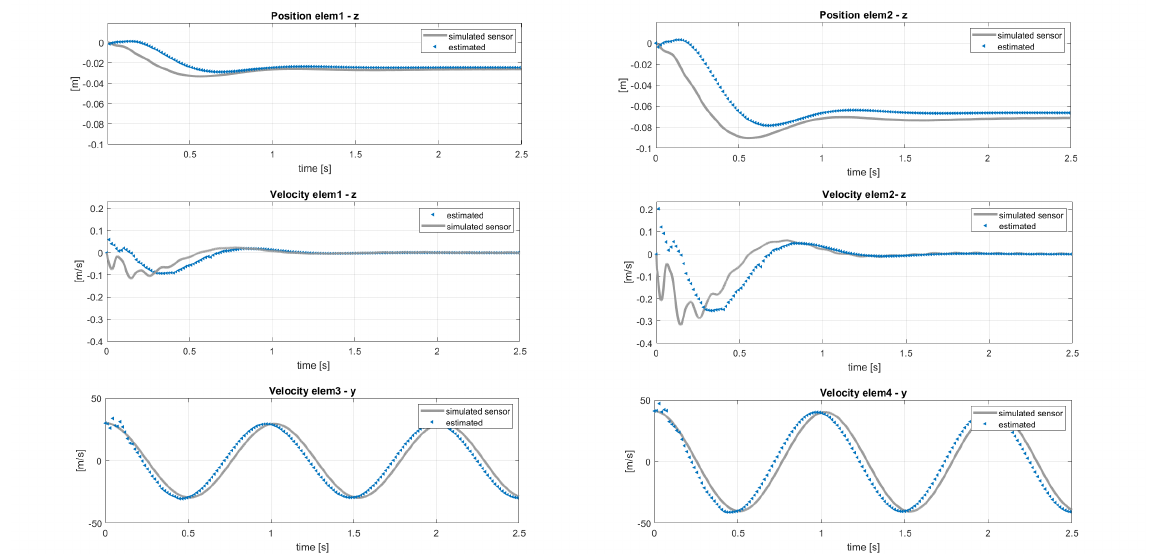
Figure 15. Estimation of the unmeasured velocity and position entities with reference to the sensor layout in Table 2. Reference data from MBDyn.